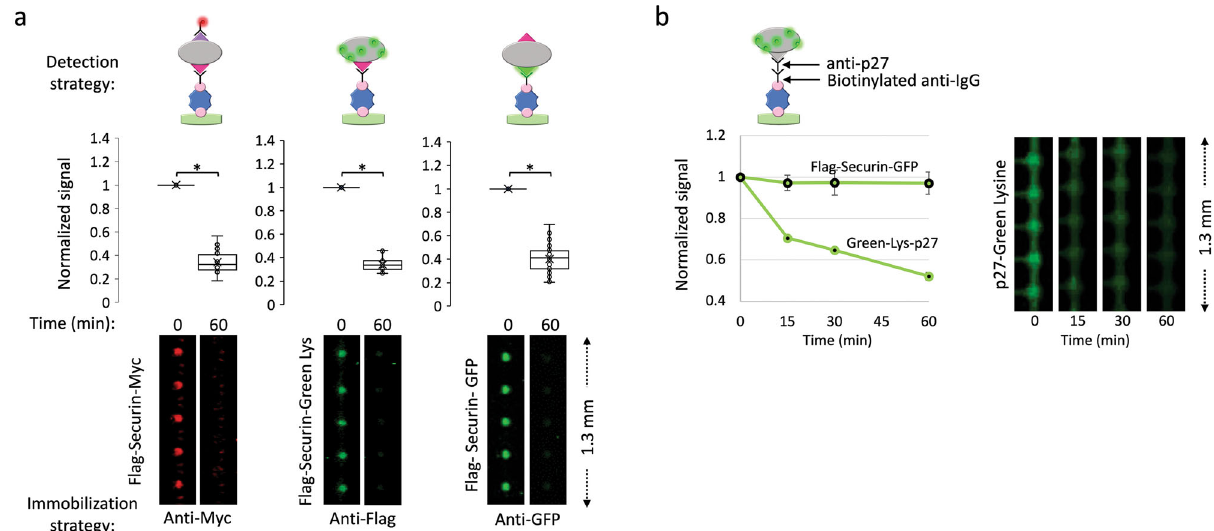
Fig. 3 Method versatility. a Degradation of Flag-Securin-Myc, Flag-Securin-GFP, and Green-Lys-labeled Flag-Securin (IVT products) in NDB mitotic extracts was assayed in tube for 1 h. On-chip analysis was performed in multiple ways: 1) Flag-Securin-Myc was immobilized by anti-Myc antibodies and detected by anti-Flag Cy5-conjugated antibodies; 2) Flag-Securin-GFP was immobilized and detected via the GFP tag; and 3) Green-Lys-labeled Flag- Securin was immobilized via anti-Flag antibodies and detected by the Green-Lys signal. Anti-Myc/Flag/GFP antibodies are biotinylated. Plots and raw data depict protein levels at t 0 vs. t 60 min . Signals are normalized to max values at t 0 . Mean values and standard error bars are shown; n = 20 – 40 cell units. * p value < 0.001. b Degradation of Green-Lys-labeled p27 (untagged) and Flag-Securin-GFP was assayed in S-phase extracts and analyzed by pDOC. p27 was immobilized via biotinylated anti-mouse IgG and anti-p27 antibodies. The Green-Lys signal was used for detection. Flag-Securin-GFP was immobilized via biotinylated anti-Flag antibodies. Following incubation with cell extracts, protein levels were quanti fi ed by GFP or Green-Lys fl uorescence in 15 min intervals. Plots depict mean and standard error values normalized to max signal at t 0 . n = 20 (p27) and 10 (Securin) cell